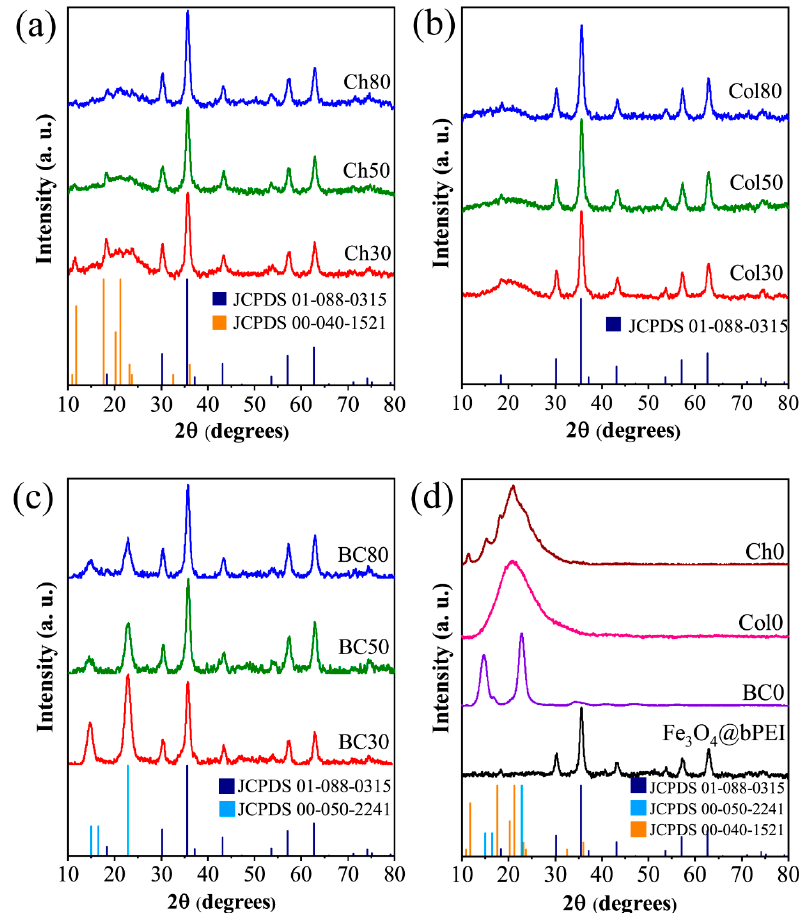
Figure 2. X-ray patterns of ( a ) Chitosan films; ( b ) Collagen films; ( c ) Bacterial cellulose films; and ( d ) Pure components of biocomposite films.